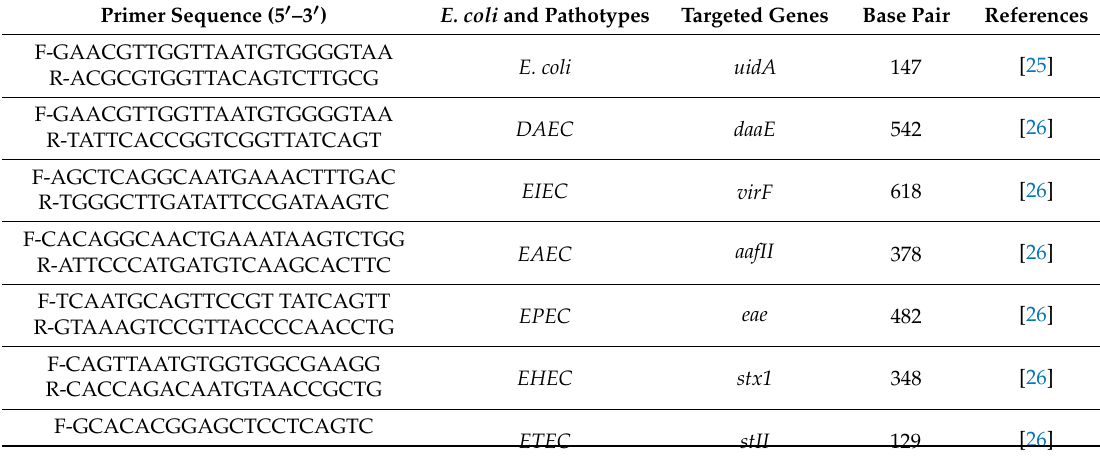
Table 1. Primers sets for uidA gene of E. coli and various genes of E. coli